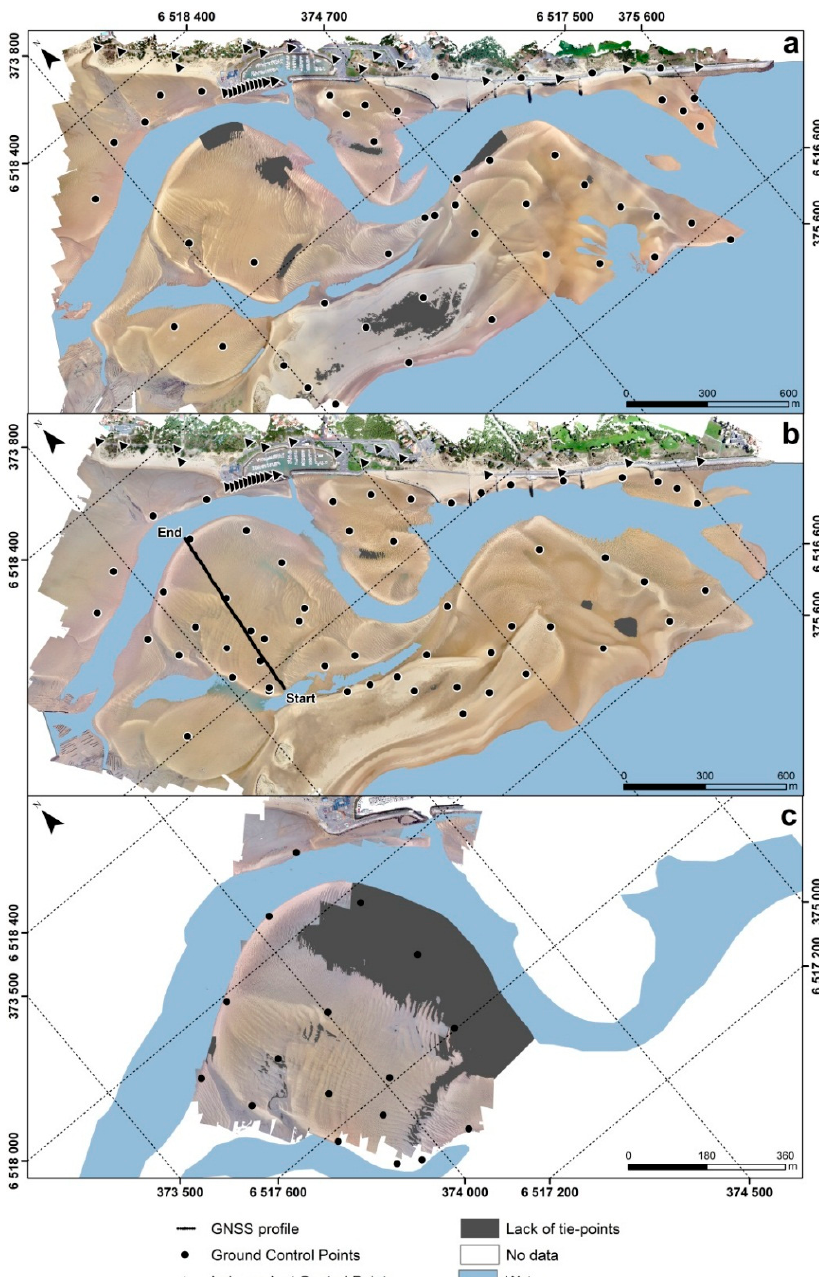
Figure 4. Orthomosaics of the three campaigns: ( a ) campaign 1; ( b ) campaign 2 and ( c ) campaign 3. Location of the GCPs (black circles), the ICPs (black triangles) and the profile used to estimate the accuracy of the DSMs. The grey areas correspond to areas where the photogrammetric processes failed due to the lack of tie points. White areas correspond to areas where no data were available. Blue areas correspond to subtidal/water areas.